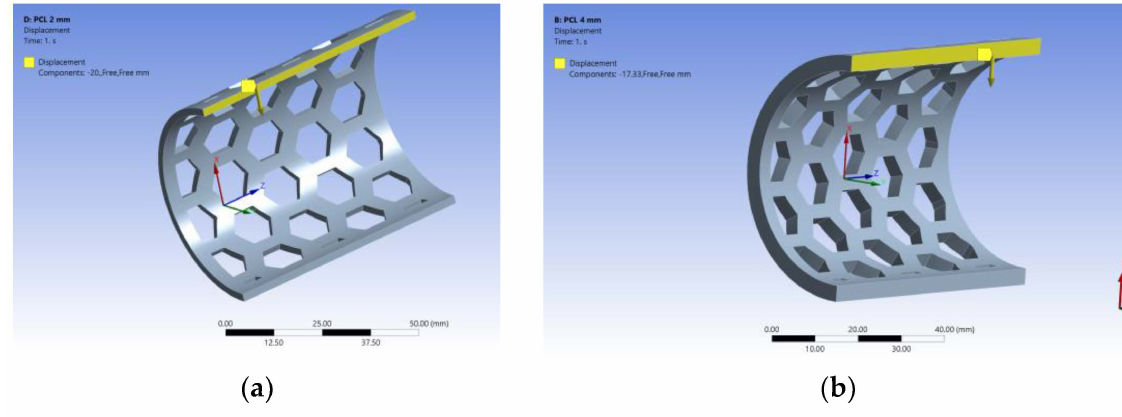
Figure 14. Loading the model of 2 mm thickness ( a ) and 4 mm thickness ( b